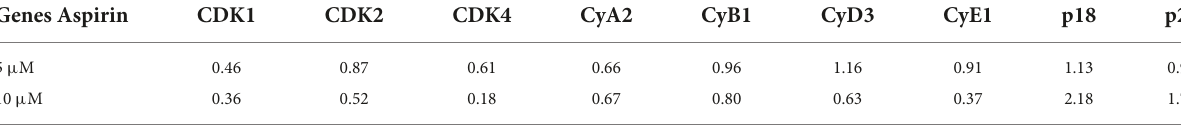
TABLE 6 The expression of cell cycle-associated genes in aspirin-treated N2a cells. Genes Aspirin